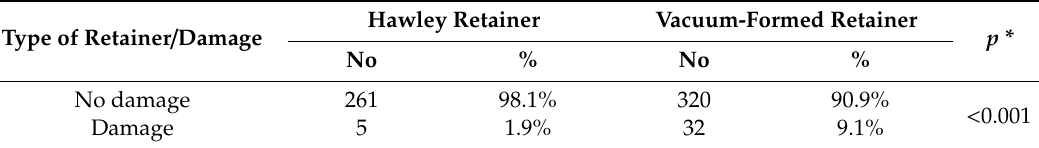
Table 3. Distribution of the patients according to the occurrence of damage and type of retainer. Type of Retainer /